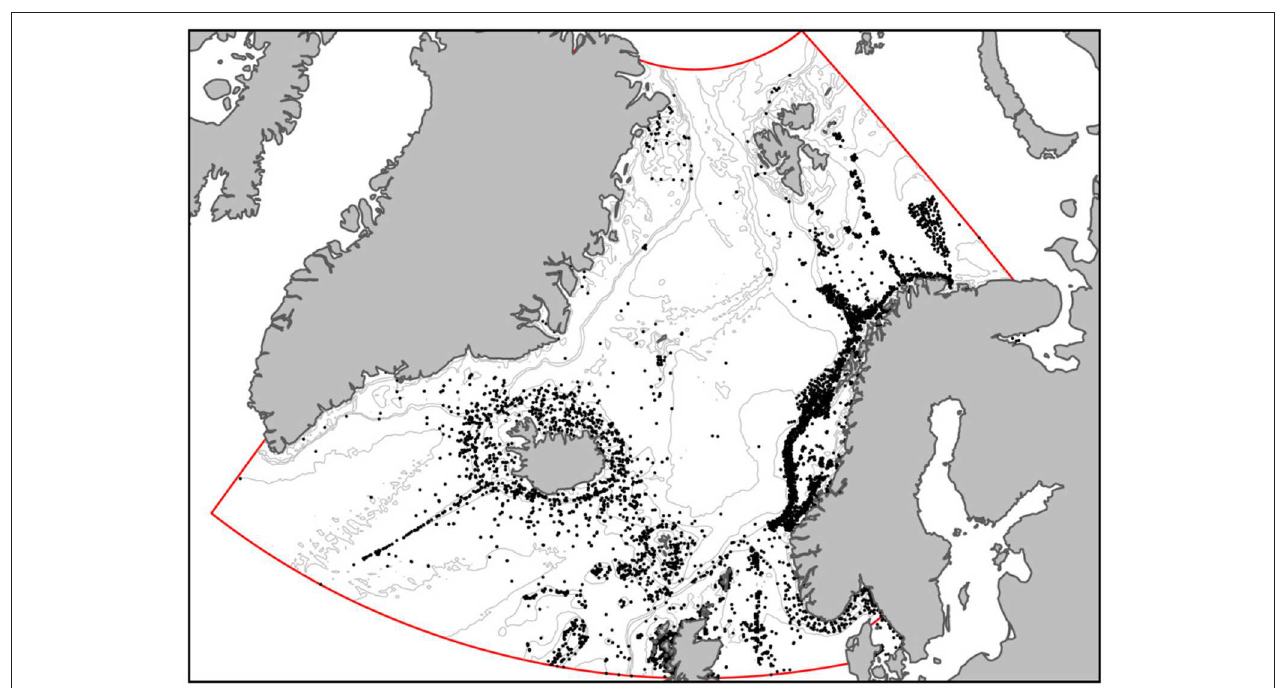
FIGURE 1 | Map of the study area, indicated by the red line. Black dots indicate the location of records of VME indicator taxa. Gray lines are the 100, 500, 1,000, and 2,500 m depth